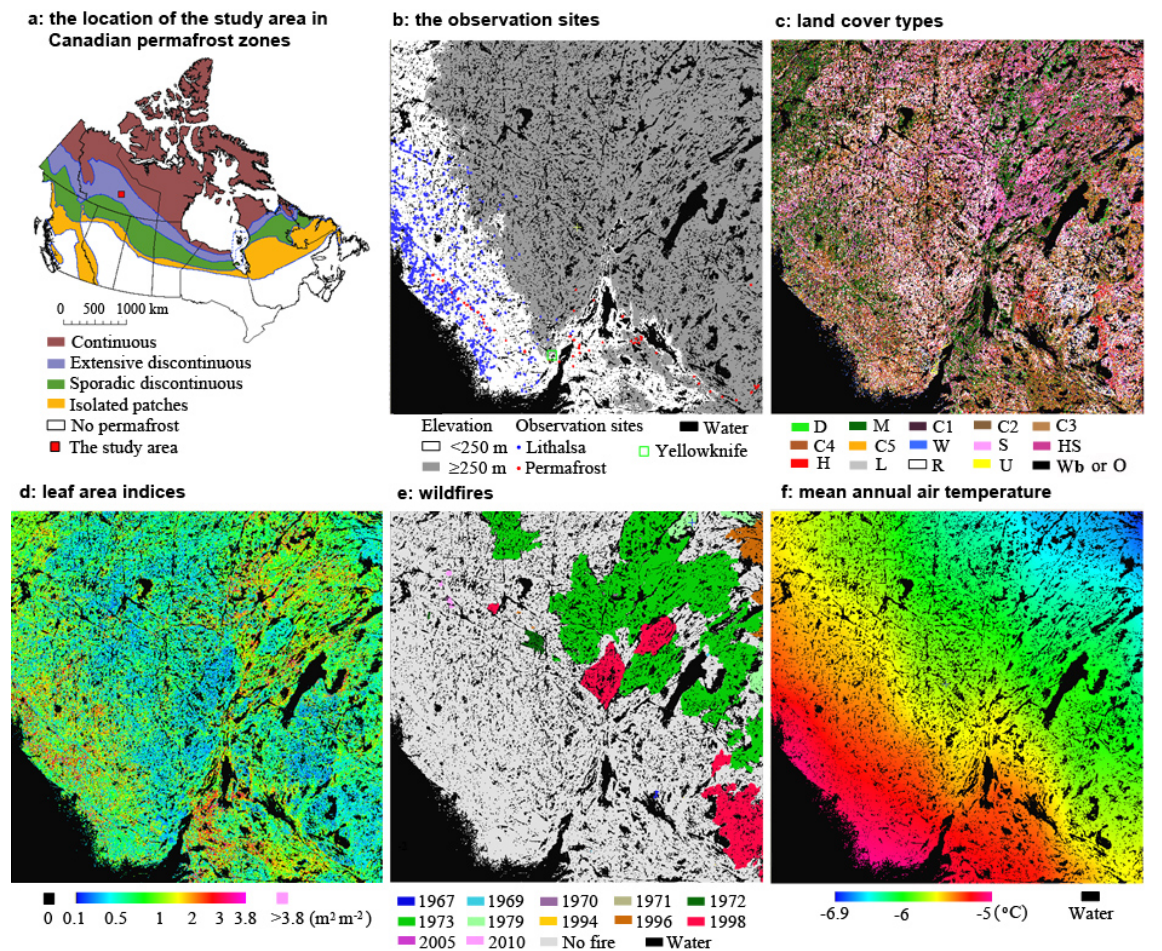
Figure 3. (a) The location of the study area in Canadian permafrost zones (Heginbottom et al., 1995), (b) the observation sites and the two regions divided based on elevation 205ma.s.l., and the distributions of (c) land cover types, (d) leaf area indices, (e) wildfires, and (f) 30-year (1971–2000) mean annual air temperature in the study